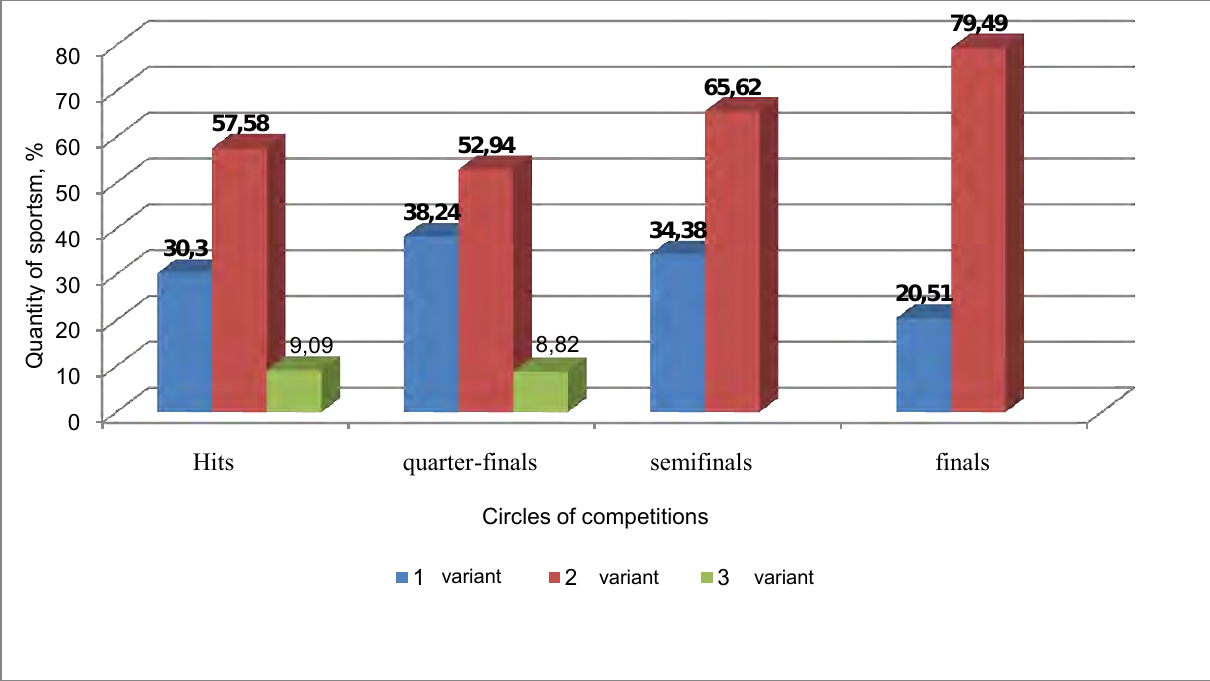
Fig.2. Using of variants of 1500 meters distance’s passing by the strongest short-trackers in different circles